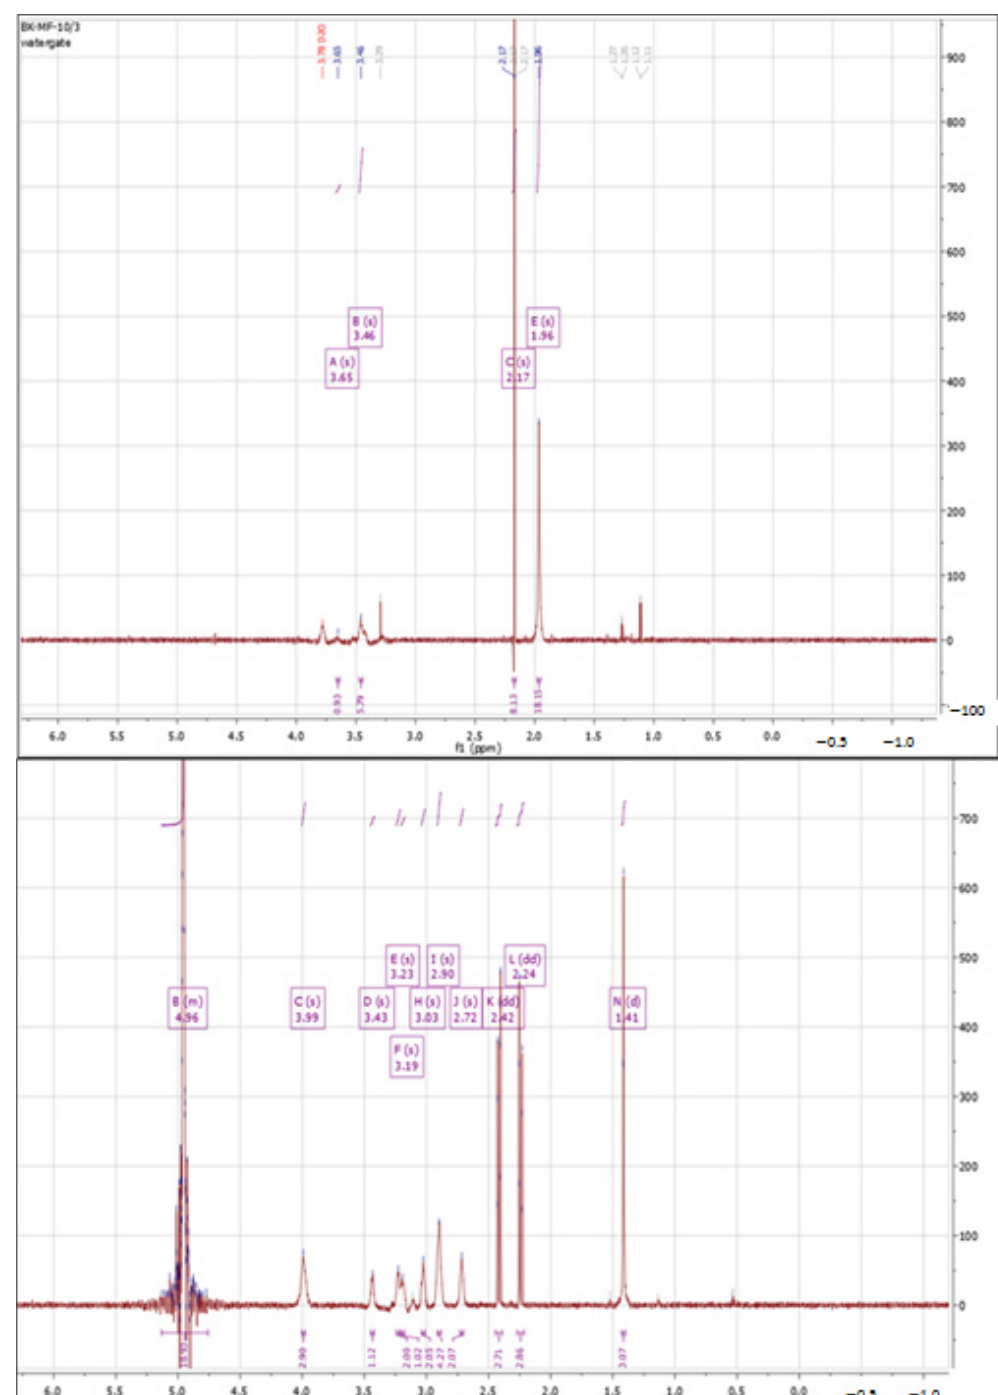
Figure 3. 1 H NMR spectra of native HA ( top ) vs. HA cross-linked with citric acid via Procedure I ( bo tt om ).